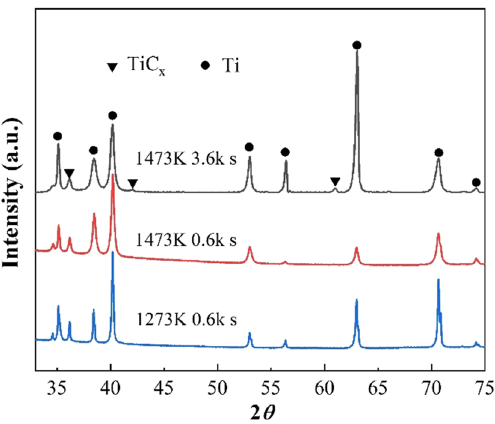
Figure 6. XRD pattern of TiC reinforced TMC sintered with different sintering temperature and heating